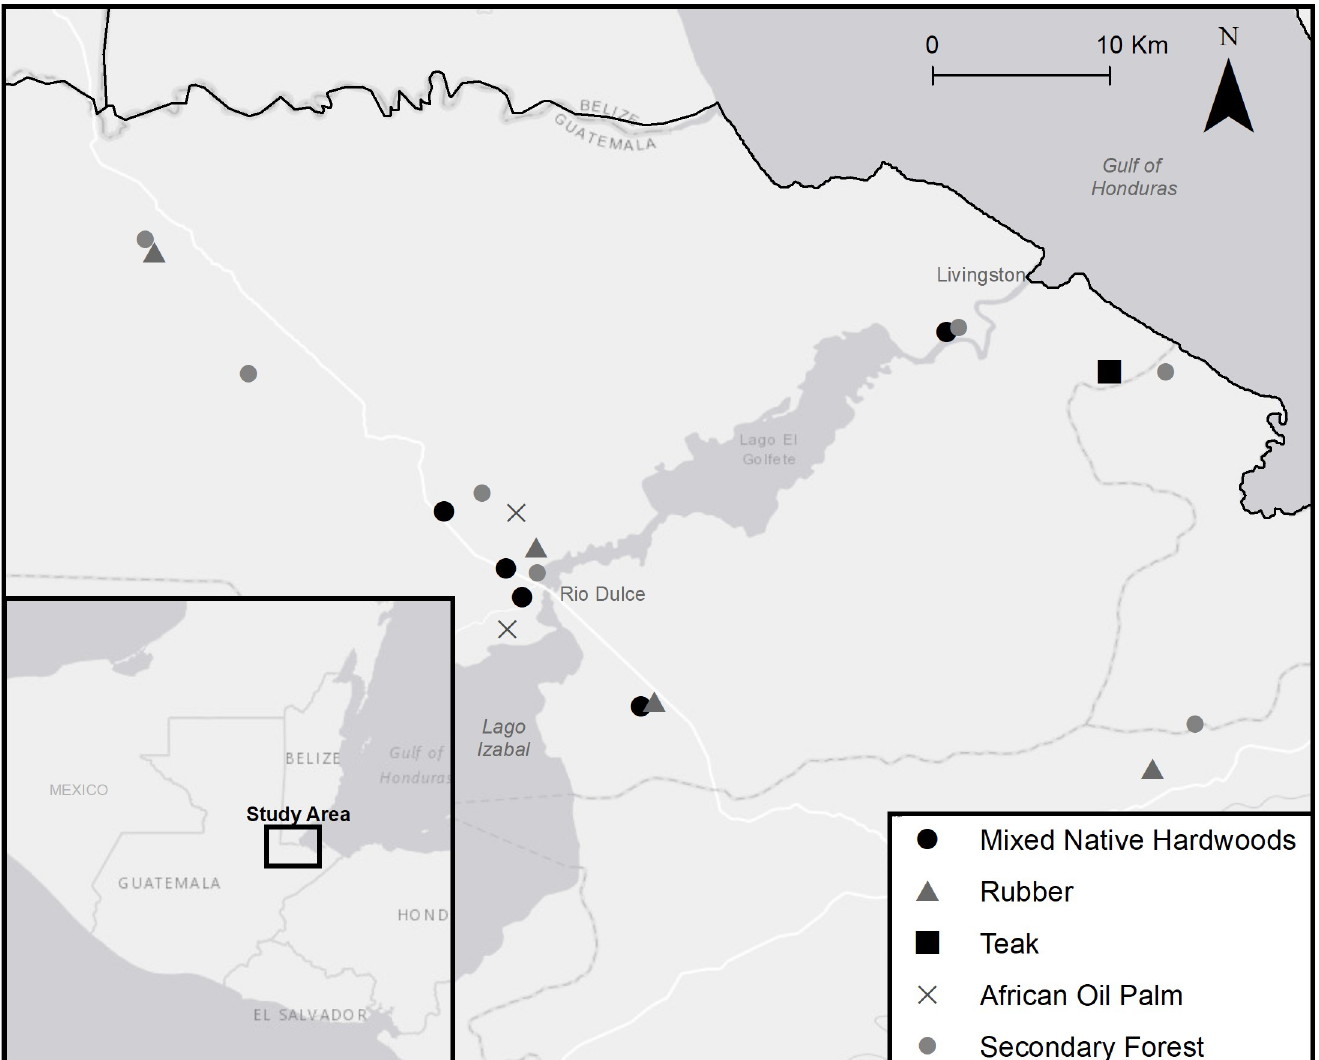
Fig 1. Map of patches surveyed in three types of hardwood plantation (mixed-native hardwoods, rubber, and teak), oil palm plantations, and native secondary forest in the Department of Izabal, Guatemala between 2015 and 2017. Locations of patches of the same cover type within 2 km were averaged to one point.